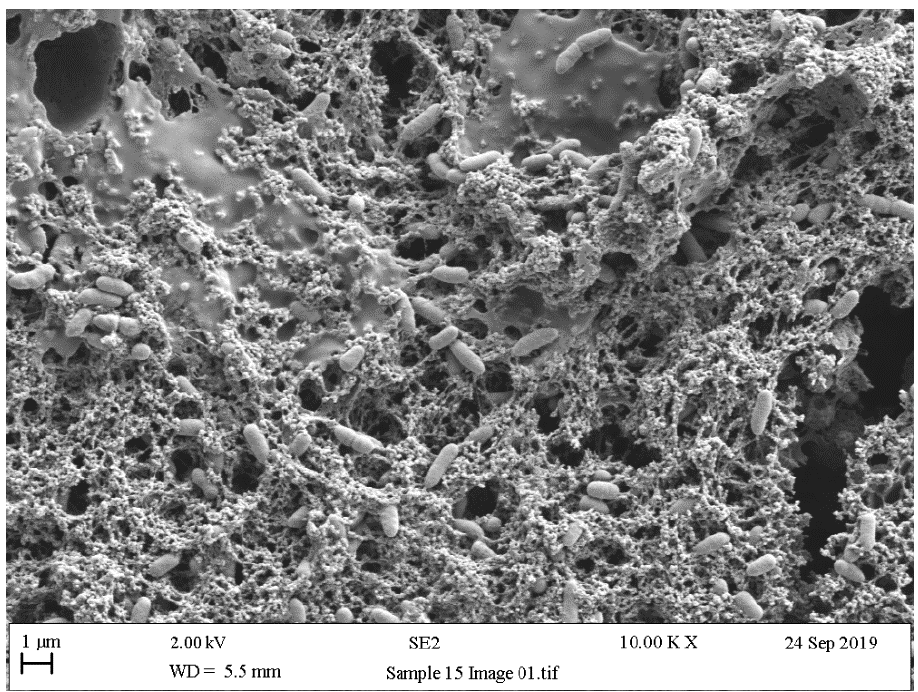
Figure 9. Scanning electronic microscopy (SEM) images of stainless steel of 3-day biofilms formed by Pseudomonas fluorescens .